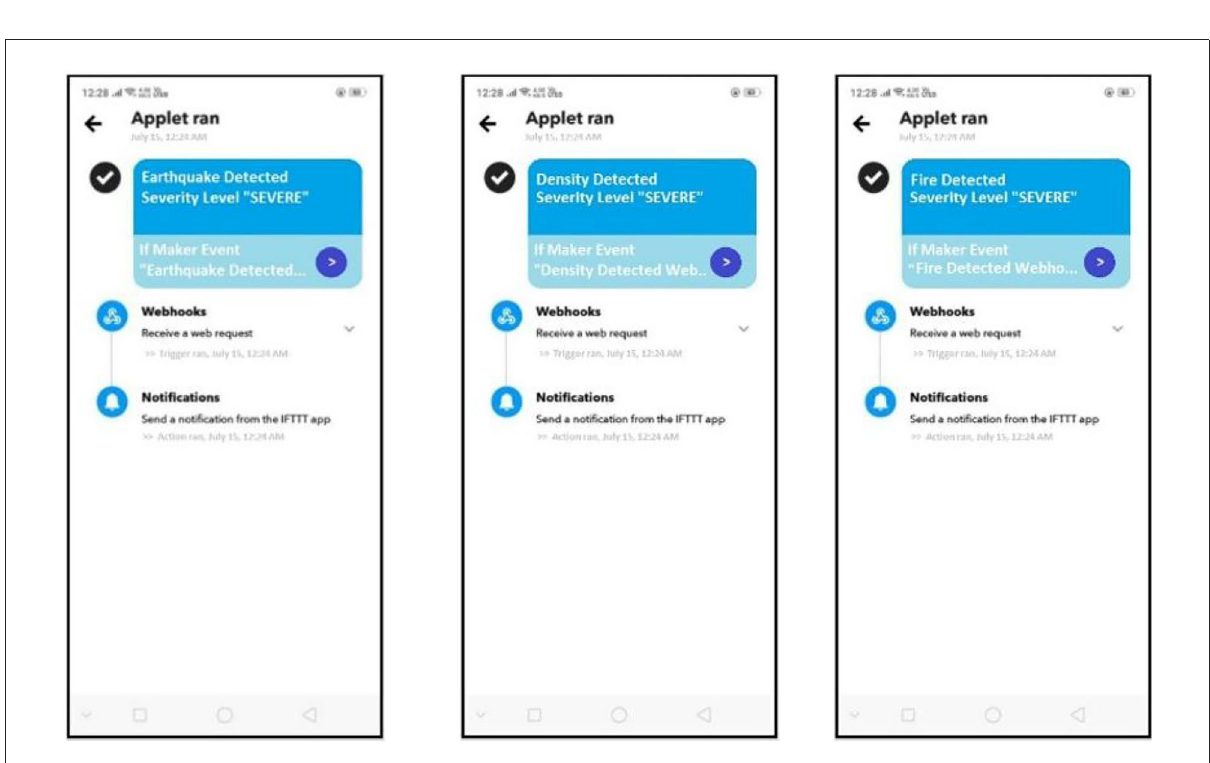
FIGURE14 IFTTT notification in the IFTTT